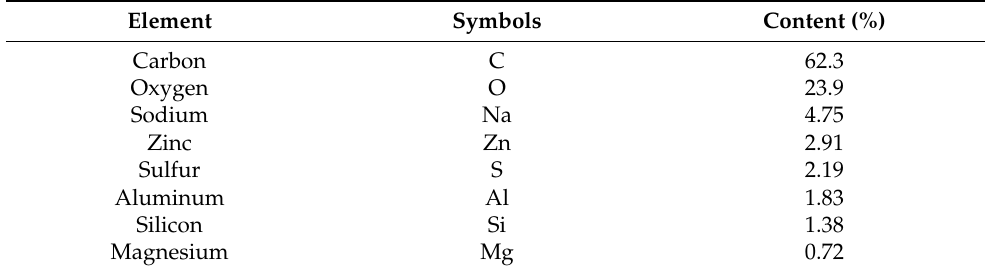
Table 3. Chemical composition (EDAX result) of WTTF